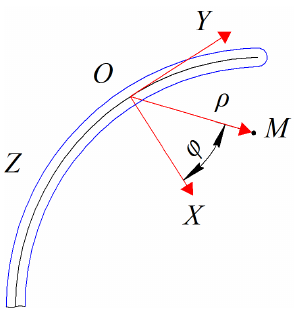
Figure 4. Definition of the coordinates of the point